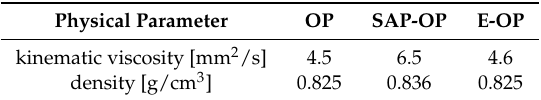
Table 3. Kinematicviscosity and density of organic phase before (OP), after (SAP-OP) saponification and after mixing with acidic water (E-OP) at phase ratio of